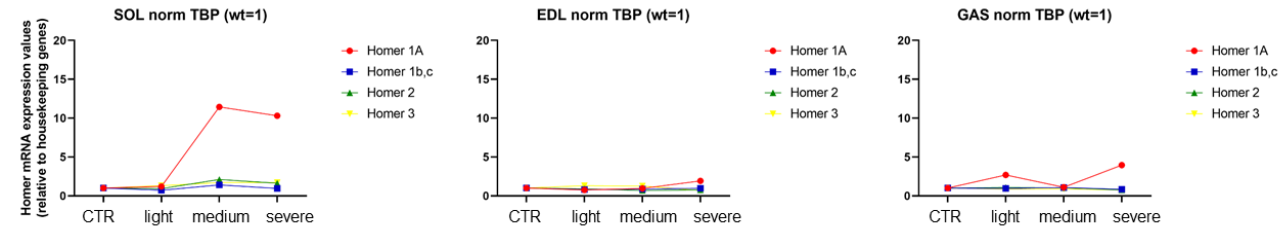
Figure 7. Overview qPCR analysis of homer gene isoforms in SOL , EDL, and GAS muscles of CTR and low, medium, severe clinical muscle weakness mice groups ( n = 5, 4, 4, 4 mice per experimental group, respectively). An increase of Homer 1a in SOL is apparently associated with the increase of severe clinical muscle weakness. Data are normalised to TATA-box-binding protein (TBP1) and are expressed as means ± SEM over CTR. For calculation, comparisons were made by Mann–Whitney-U test, with p ≤ 0.05 being considered statistically significant.